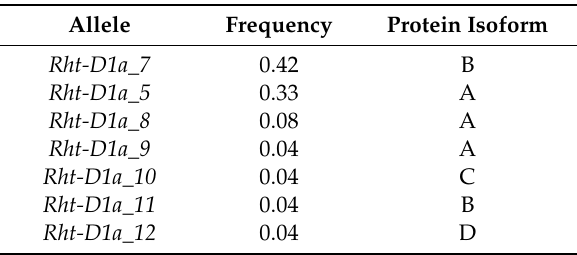
Table 1. Frequencies of the Rht-D1 alleles within the studied collection of Ae. tauschii accessions and corresponding protein isoforms.